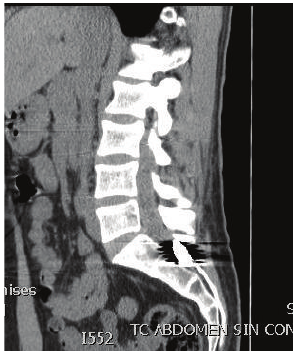
Figure 1: Sagital CT scan shows the bullet lodged at the S2 level.